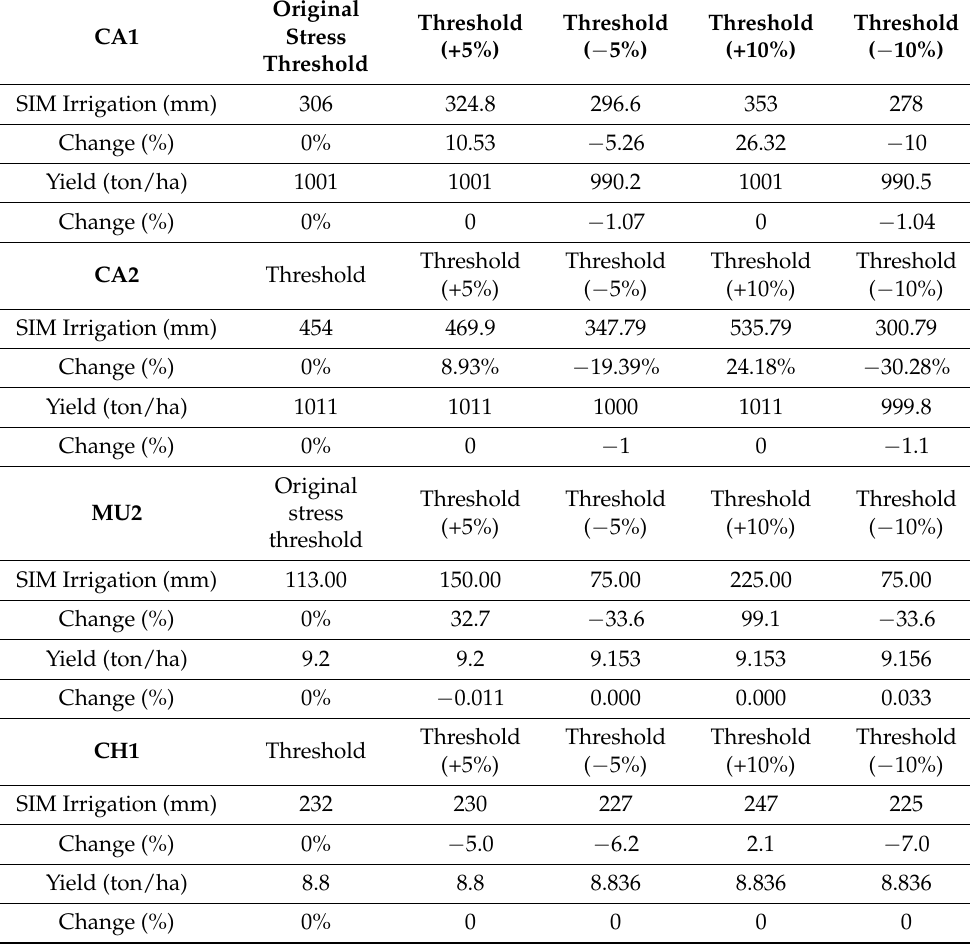
Table 8. Effect of SM stress threshold on irrigation amount and crop